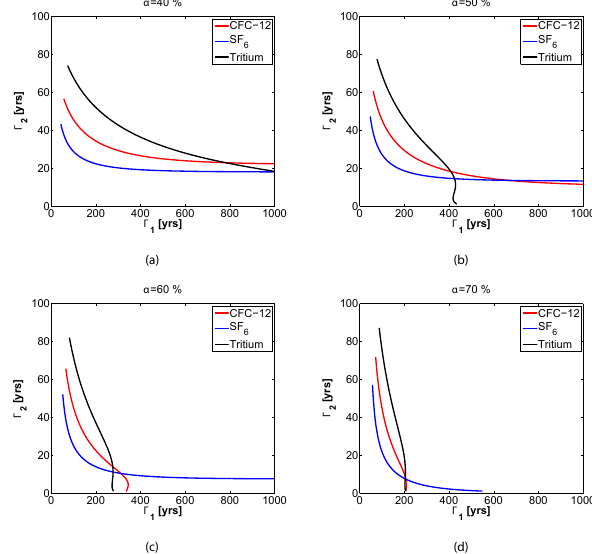
Figure 18. Example for a mean age calculation from three transient tracers (CFC-12, SF 6 and tritium) at station 305 at 608m depth. Panel ( d ) shows a triple intersection of all three transient tracer con- centrations ( α = 70%) and thus a solution for the mean age at this data point of 147